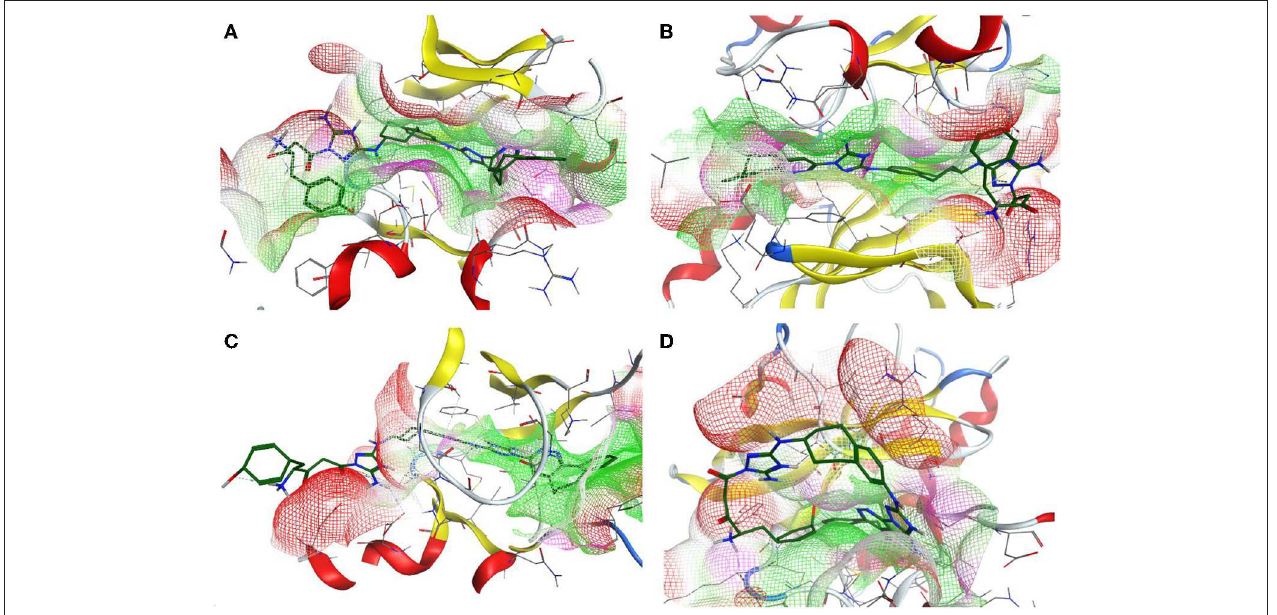
FIGURE 9 | The 3D representation of the compound designed, R5, inside the binding pocket of the Axl (A) , Tyro3 (B) , ABL1 (C) , and MET (D) kinases. The pocket is shown as a van der Waals surface representation. The hydrophobic parts inside the pocket are shown in green , the hydrophilic parts are shown in purple , and the hydrogen bond acceptors are shown in red . The ligand is shown as a licorice representation and depicted in forest green